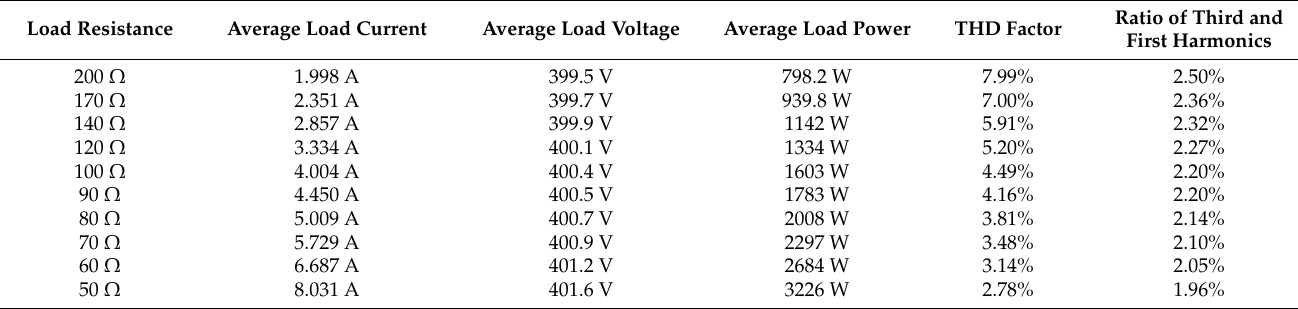
Figure 15. Results of the harmonic analysis for a single period (marked red) of the current drawn from the AC line by the simulated circuit at p = 2 kW. Total harmonic distortion was reduced to 3.81%, and the results are promising for ensuring a standard compliance. Table 2. Performance of the power factor corrector (PFC) for various load resistances. The following quantities are provided: the load power, the average load current, the average load voltage, the total harmonic distortion (THD) factor for the AC line current, and the ratio of AC line current harmonics—the third to the first. All simulation results correspond to the steady-state